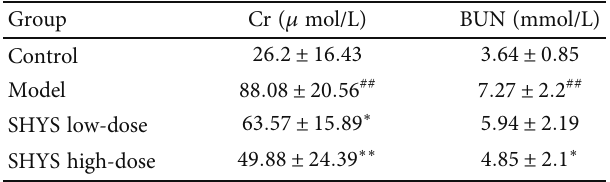
Control, model, SHYS low-dose, SHYS high-dose groups ( n = 10 per group) ## : P < 0 : 01 compared with the control group; ∗ : P < 0 : 05 compared with the model group; ∗∗ : P < 0 : 01 compared with the model group. Table 2: E ff ects of SHYS on FINS and HOMA-IR. Group FINS ( μ IU/ml) HOMA-IR